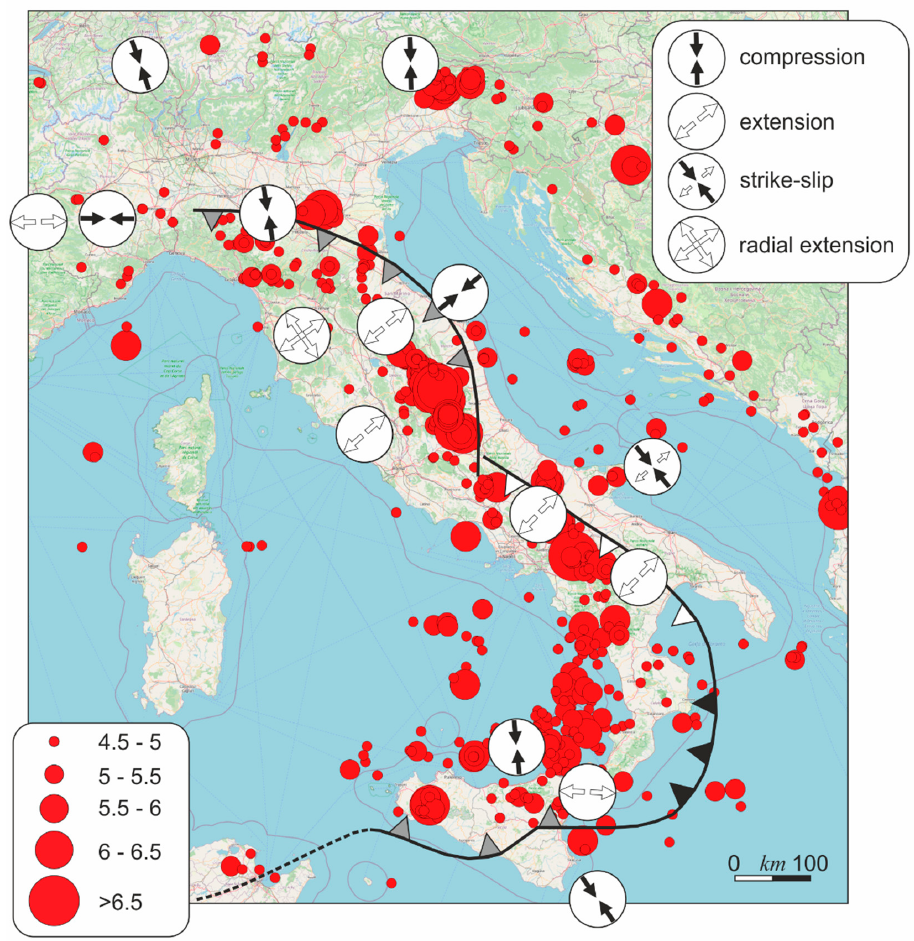
Figure 9. Seismic events (red dots) with M W ≥ 4.5 occurred in Italy from 1960 to 2021 within a radius of 600 km from Roma. Seismic information has been kept from the Italian earthquake catalogue CPTI15 [69] and from the Italian Seismological Instrumental and Parametric Database (ISIDe; http: //iside.rm.ingv.it), compared with stress field in Italy (redrawn after [84]). Bold lines = structural arcs; shaded triangles = active compressional fronts; solid triangles = active oceanic subduction; open triangles = front of the Plio-Pleistocene thrust, now prevalently affected by exten- sion.